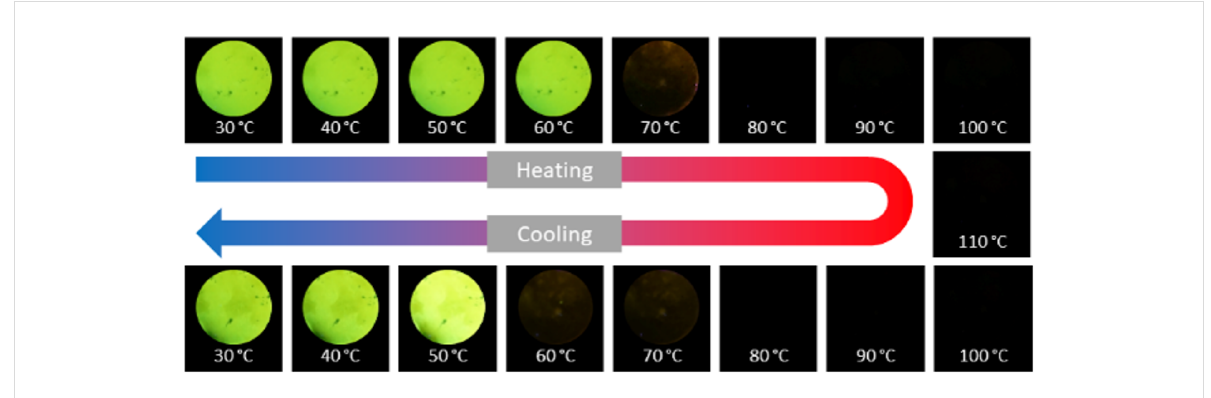
Figure 9: Temperature-dependent fluorescent images of NO 2 -C 9 ∙∙∙ F 4 St showing the enhancement of emission upon aggregation at room tempera- ture ( λ ex = 365 nm).